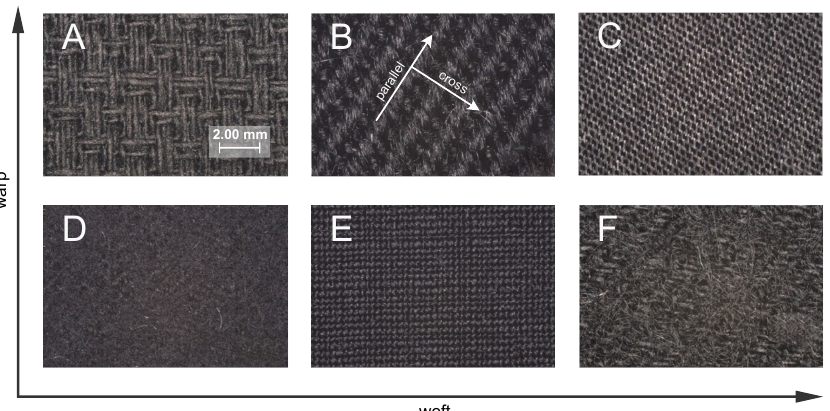
Figure 1. Photographs of the surface structures of the samples with weave directions. ( A – F ) Six woven fabric samples with different weave structures and surface roughness values were used in this